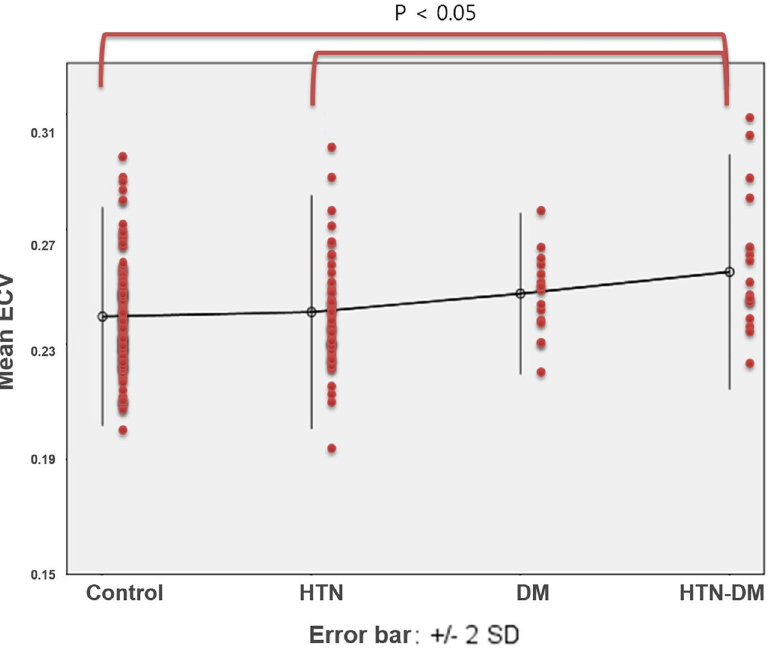
Figure 2. Relation of extracellular volume fraction (ECV) with hypertension (HTN) and diabetes mellitus (DM). HTN-DM group showed significantly higher ECV (0.260 ± 0.023) than control (0.240 ± 0.021, p = 0.011) and HTN groups (0.241 ± 0.024, p = 0.041). Error bars indicate 2 standard deviations (SDs) from average.